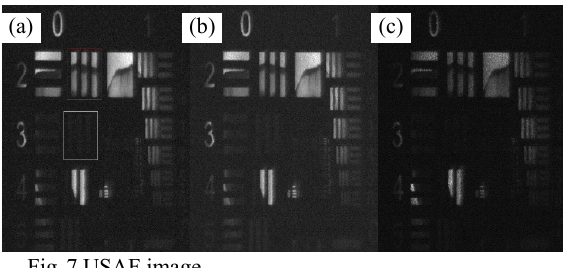
Fig. 7 USAF image.